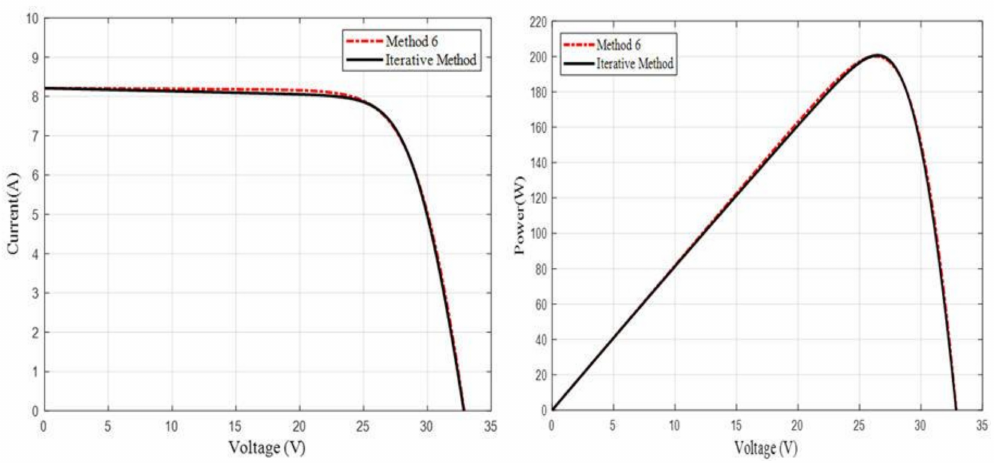
Figure 8. Comparison between the I–V ( left ) and P–V ( right ) curves obtained using Method six with those obtained using numerical method for the KC200GT